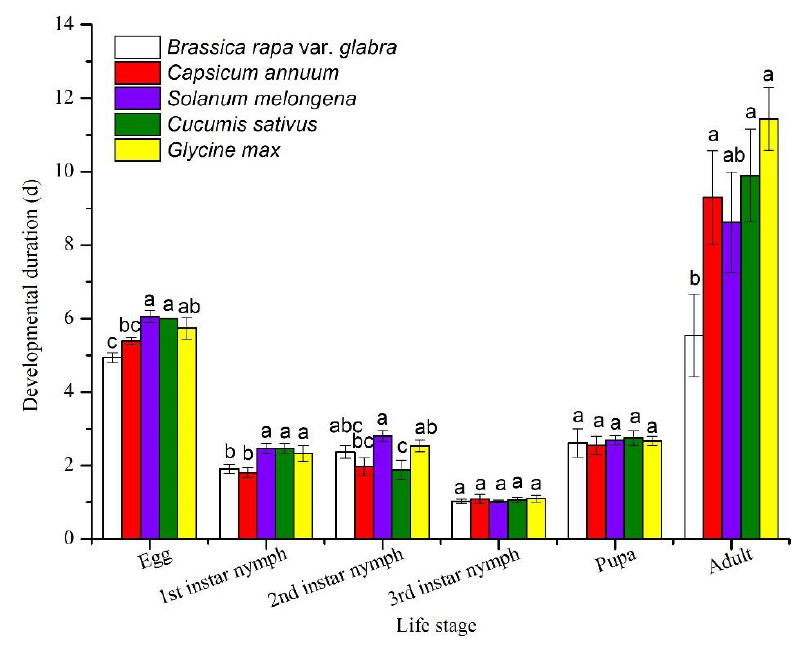
Figure 1. Developmental durations of Thrips flavus fed on different plants. Different letters indicate significant differences among different treatments at the 0.05 level.